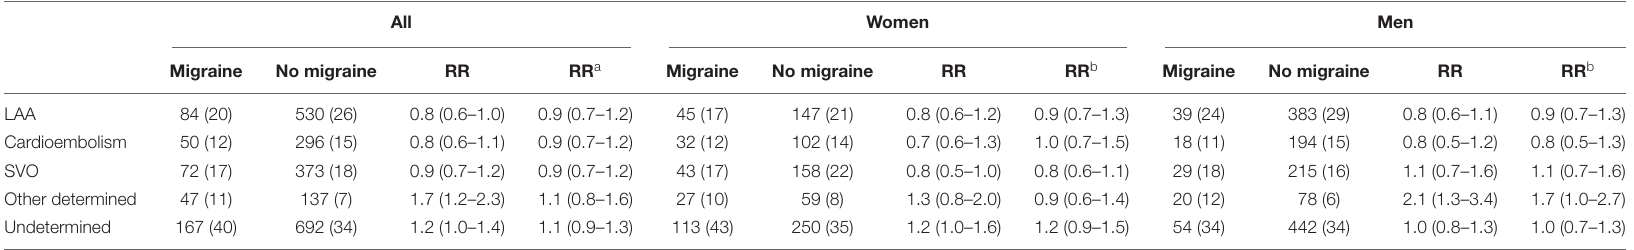
TABLE 2 | Stroke subtype according to TOAST classification.